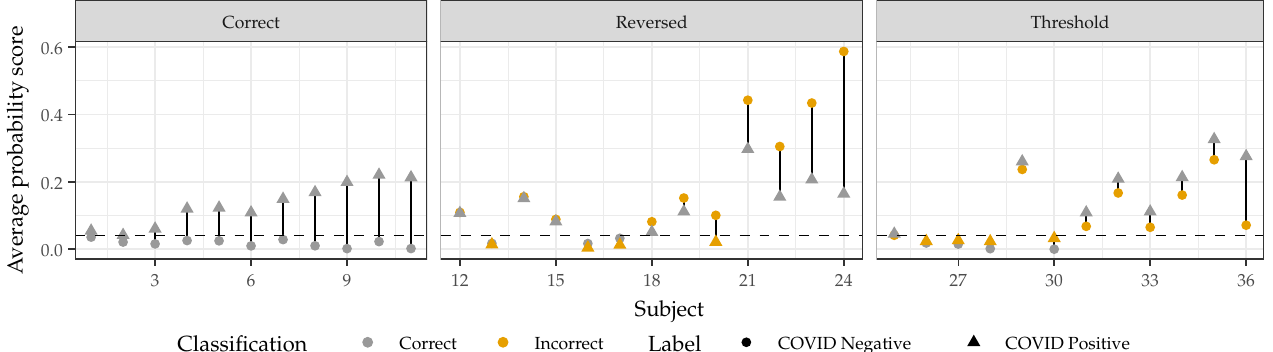
Figure 10. The predicted probability scores for subjects in the Social Media Dataset whose non- COVID and COVID recordings were tested on the system. The predicted probability scores illustrate that the system is able to detect differences in the subject’s non-COVID and COVID recordings; however, the threshold value limits the system’s ability to make accurate